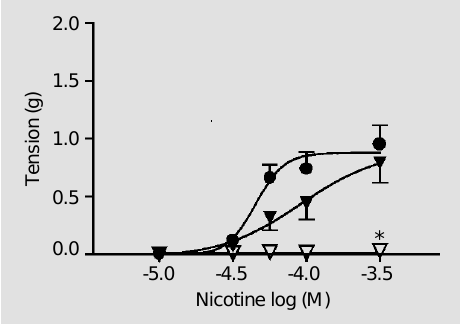
Figure 4 - Effect of endogenous and exogenous melatonin on mecamylamine (10 nM) inhibi- tion of the noncumulative con- centration-effect curve for nico- tine in the prostatic portion of the rat vas deferens. Animals were killed at 15:00 h and vasa deferentia were incubated (closed triangles, N = 8) or not (open triangles, N = 6) with